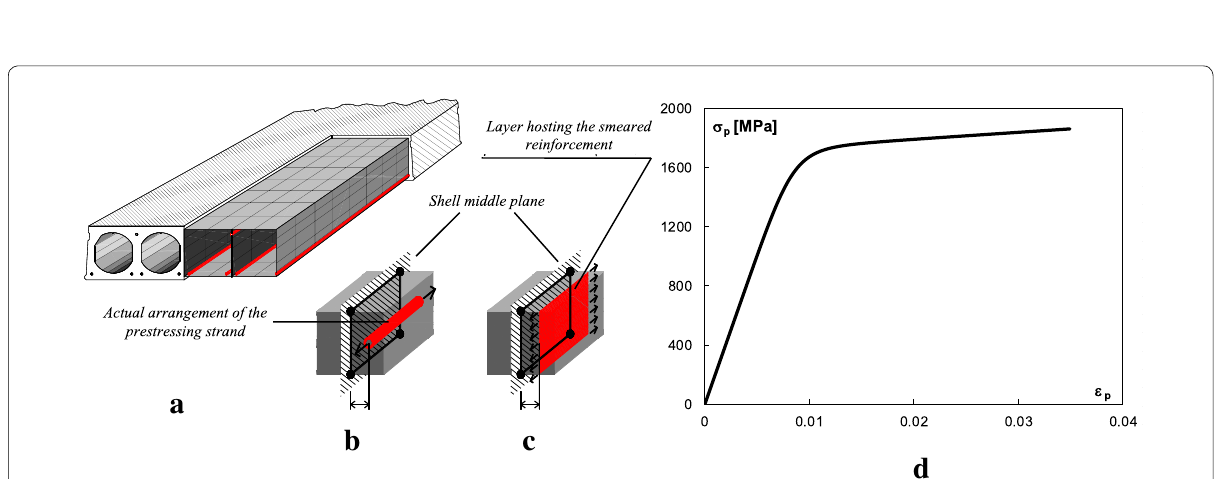
Fig. 11 a Modeling of prestressing strands through ABAQUS “rebar layer” option; b definition of rebar offset with respect to shell middle plane; c rebar layer smeared within the shell element; d elastic-hardening stress–strain law assumed in numerical analyses for prestressing